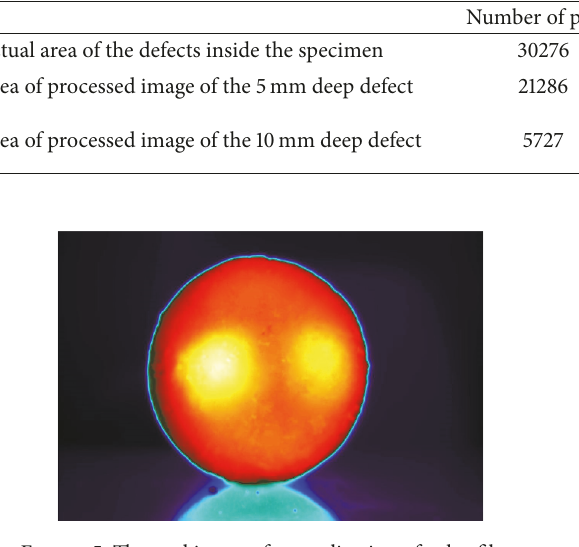
Figure 5: Thermal image after application of color filter.